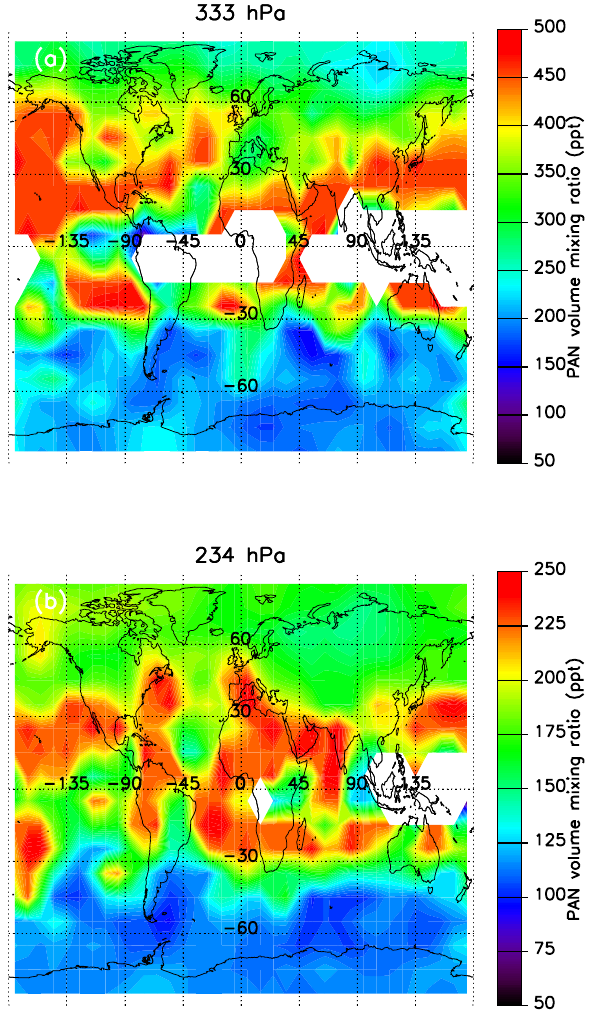
Fig. 7. Global PAN distributions (in units ofppt) at average pressure levels of 333hPa (a) and 234hPa (b) averaged for the month of March 2003. White areas are cloud contaminated regions.